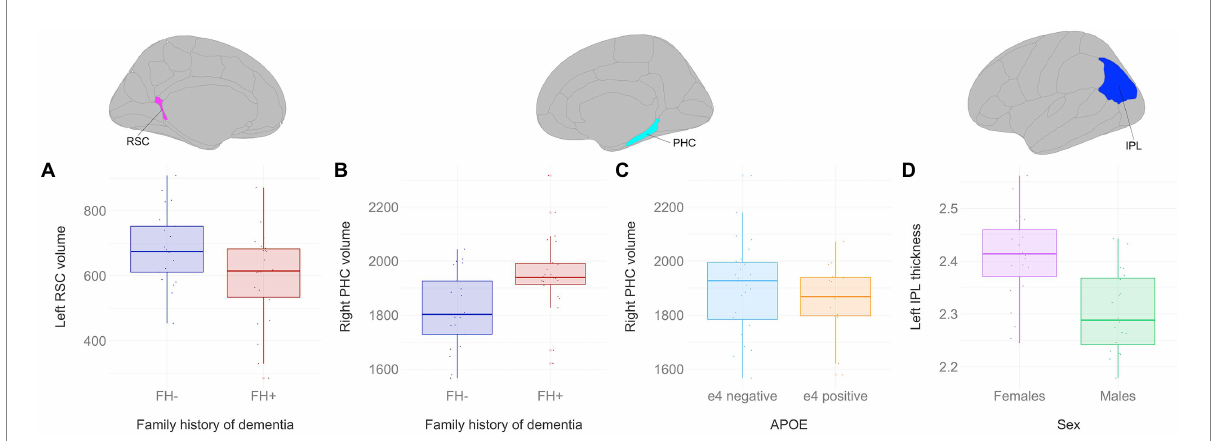
FIGURE 4 Grey matter volume and thickness differences between participant groups. Significant results shown from three-way ANOVAs. Individuals with a family history of dementia had (A) lower left retrosplenial volumes (F 1,43 = 6.903, p < 0.05), but (B) greater right parahippocampal volumes compared to individuals without a family history of dementia (F 1,43 = 14.2647, p < 0.01). (C) APOE e4 carriers had lower right parahippocampal volumes compared to non-carriers (F 1,43 = 5.4288, p < 0.05). (D) Males had lower cortical thickness in the left inferior parietal lobule compared to females (F 1,43 = 10.1512, p < 0.01). Brain figures made with “ggseg” R package (Mowinckel and Vidal-Piñeiro, 2020). RSC, retrosplenial cortex; PHC, parahippocampal cortex; IPL, inferior parietal lobule; FH+, positive family history of dementia; FH − , no family history of dementia; APOE, apolipoprotein